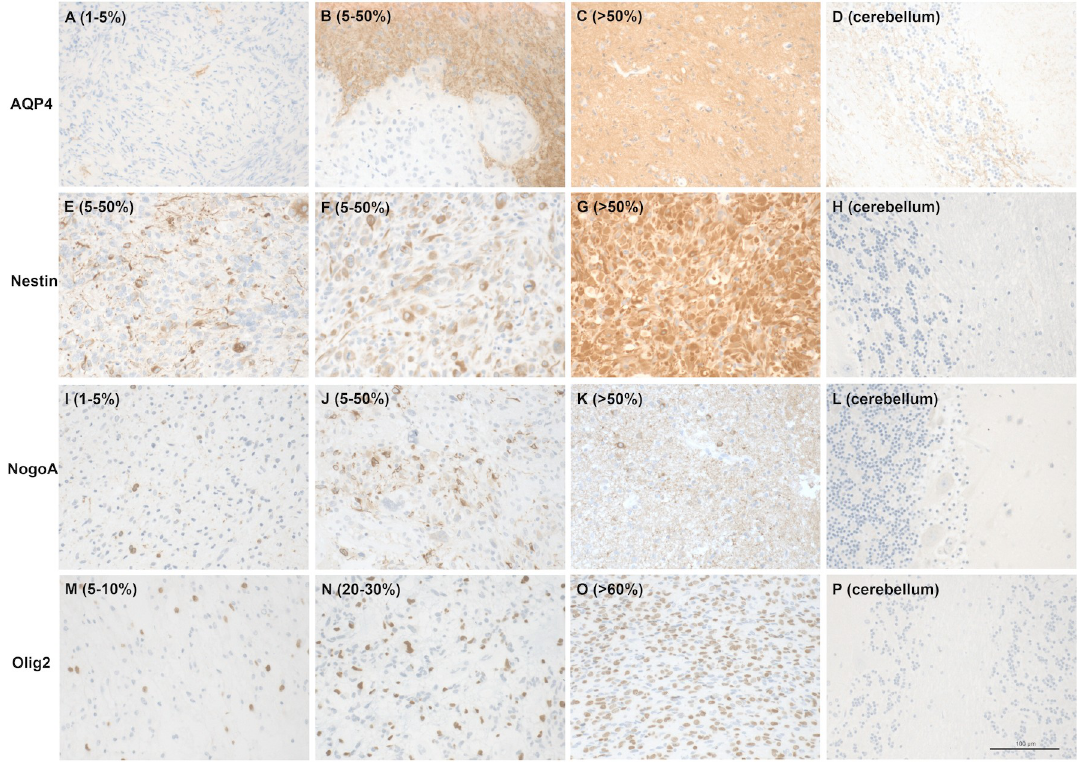
Fig 1. Images of patient samples as examples of the semiquantitative immunohistochemical scoring system for AQP4 (A: 1–5%, B: 5–50%, C: > 50%), Nestin (E: 5–50%, F: 5–50%, G: > 50%), NogoA (I: 1–5%, J: 5–50%, K: > 50%) and Olig2 (M: 5–10%, N: 20–30%, O: > 60%). Non-neoplastic cerebellar tissue (D, H, L and P) was used as a negative control for each staining. Magnification: